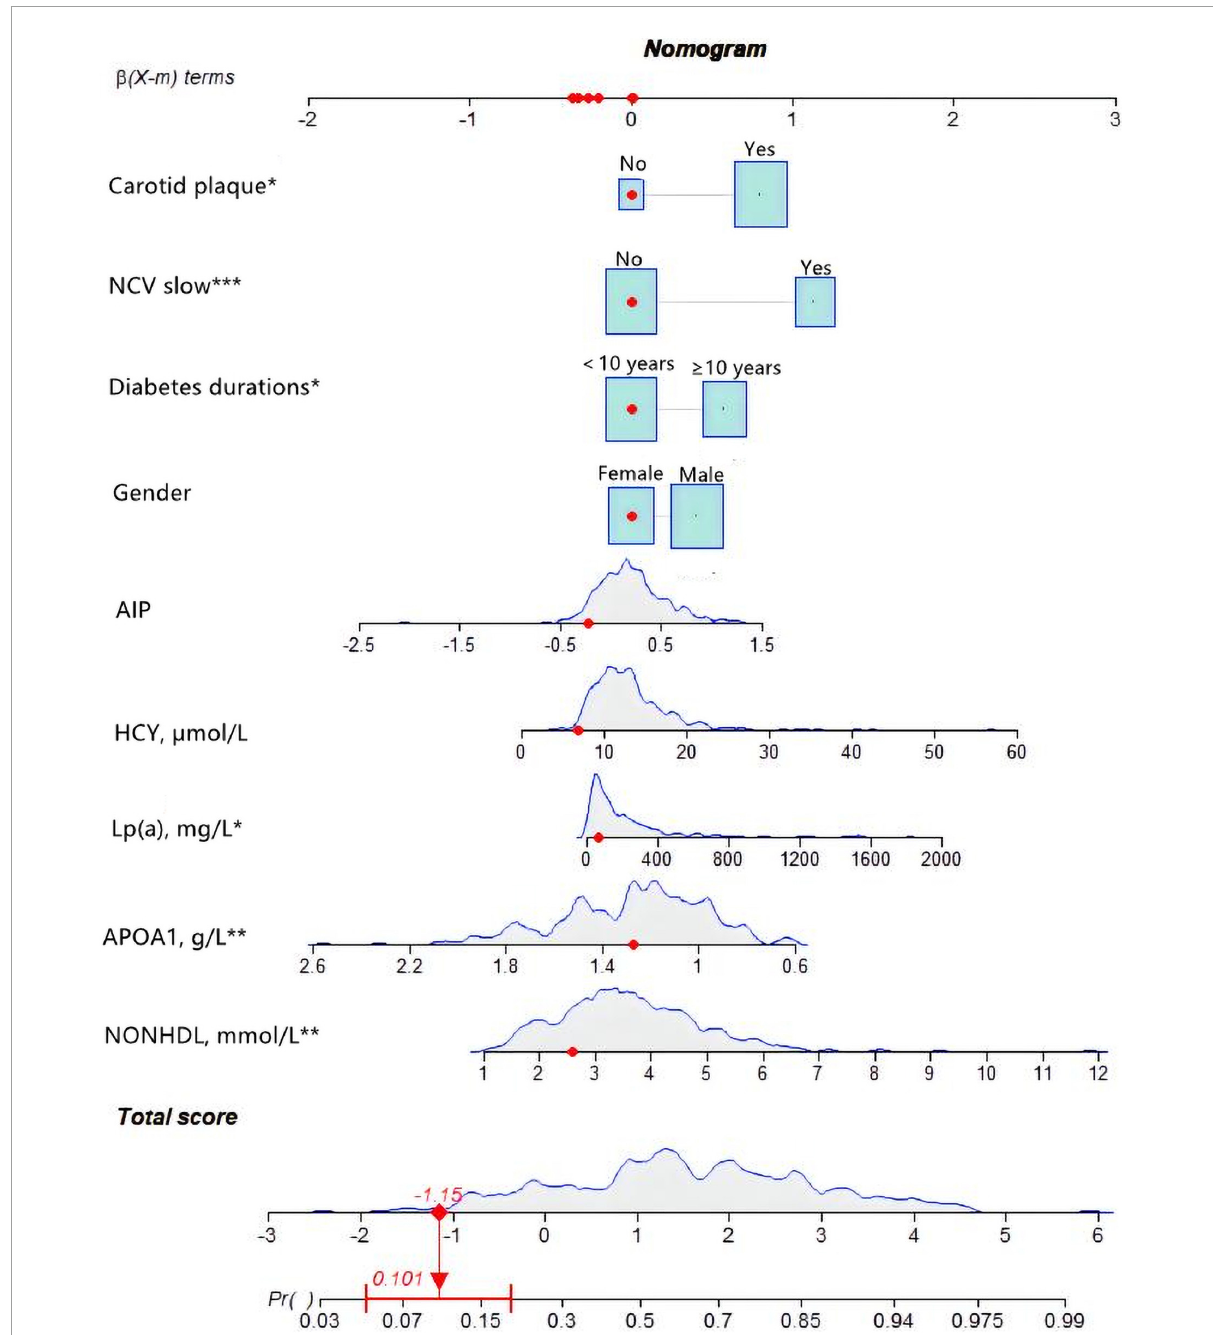
FIGURE6 An example of nomogram for coronary heart disease (CHD) in type 2 diabetes mellitus (T2DM) patients. Logistic regression results showed that there were corresponding P -values for each index, and the indicators with statistical significance level P ≤ 0.05 were included in the nomogram. “***” means P < 0.001, “**” means P < 0.01, “*” means P <